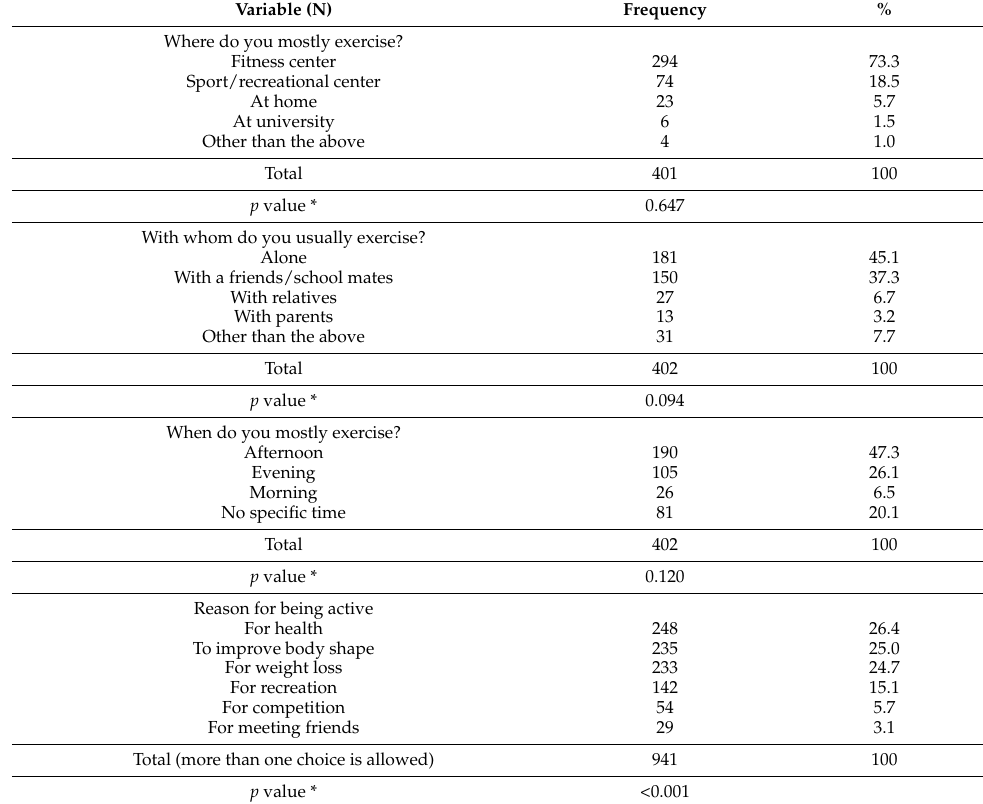
Table 4. Physical activity preferences among female